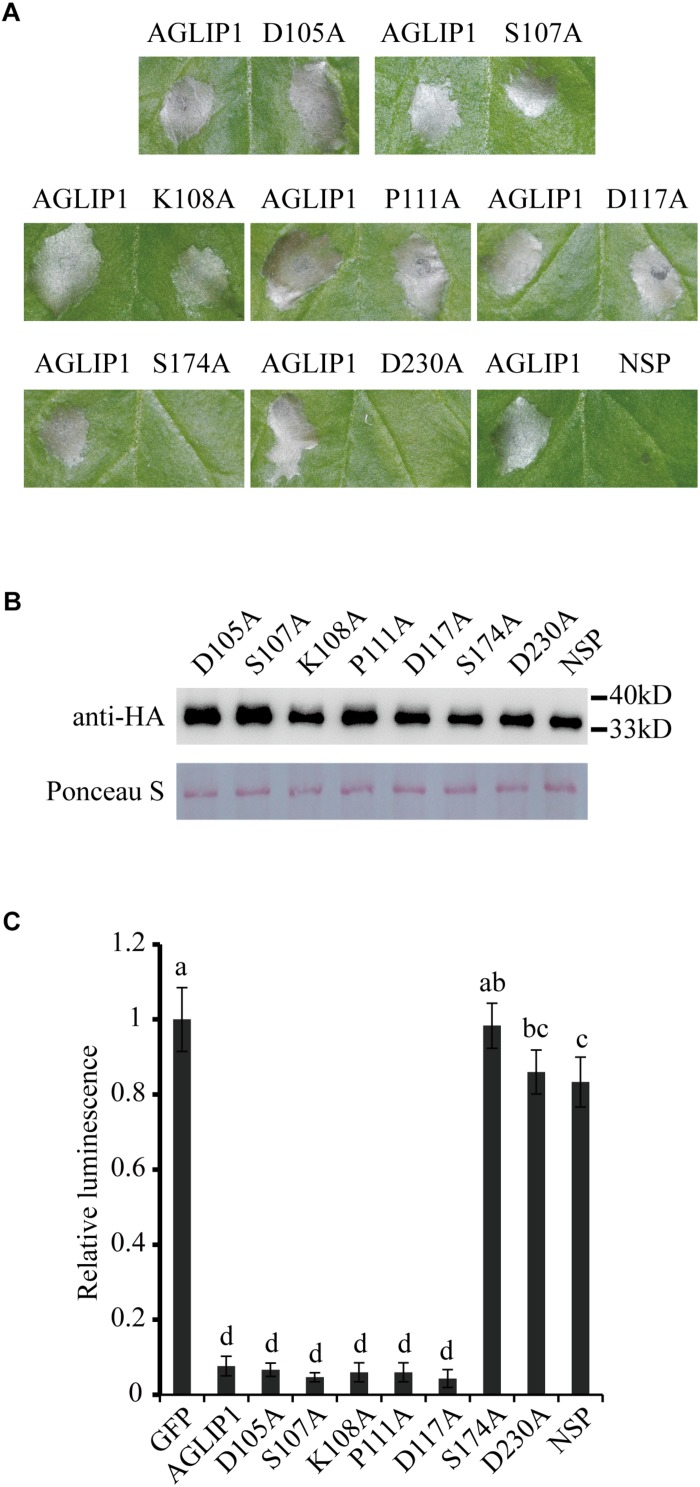
The predicted lipase active sites and signal peptide of AGLIP1 are required for its cell death-inducing ability. (A) The mutant proteins AGLIP1S174A, AGLIP1D230A and AGLIP1NSP lost the ability to induce cell death, while other variants, including AGLIP1D105A, AGLIP1S107A, AGLIP1K108A, AGLIP1P111A and AGLIP1D117A, triggered cell death symptoms on N. benthamiana leaves. (B) The protein expression level of mutant proteins in the infiltrated leaves detected by Western blotting. The equal loading of the total proteins was showed by Ponceau S staining. The samples for protein extraction were collected before the cell death symptoms were visible. The proteins with 3 × HA tag were detected by immunoblotting with an anti-HA antibody. (C) The luciferase activity in rice protoplasts was significantly inhibited by the co-expression of AGLIP and its mutant variants AGLIP1D105A, AGLIP1S107A, AGLIP1K108A, AGLIP1P111A and AGLIP1D117A, while the mutant variants AGLIP1S174A, AGLIP1D230A, and AGLIP1NSP did not. Data are means ± standard error (SE). Different letters (a through d) indicate significant differences in the luciferase activity at P < 0.05, according to Duncan’s multiple-range test.